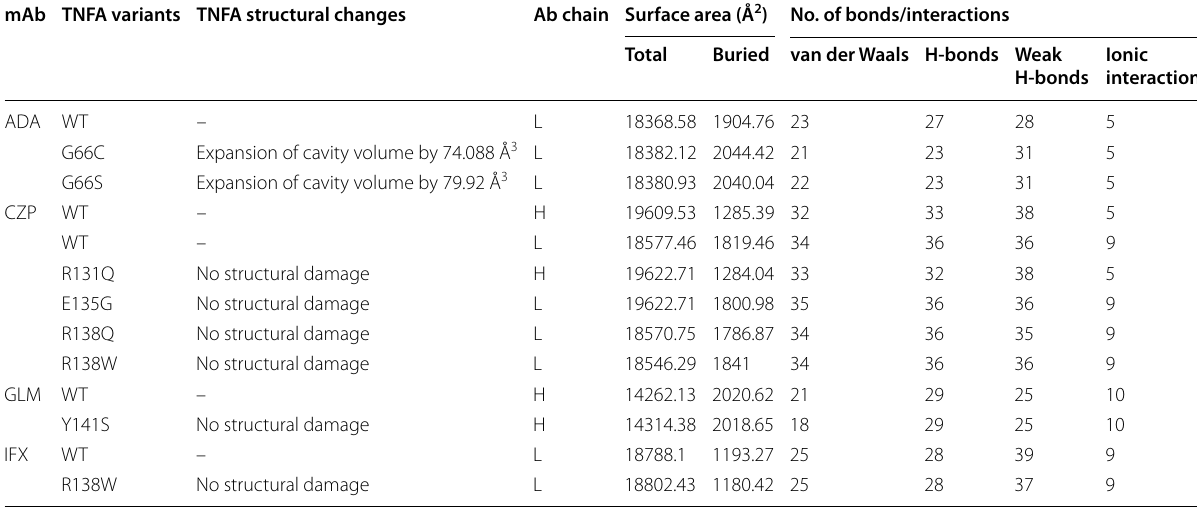
Table 6 Effects of selected variants on TNFA structure and TNFA-mAb interactions mAb TNFA variants TNFA structural changes Ab chain Surface area (Å 2 ) No. of